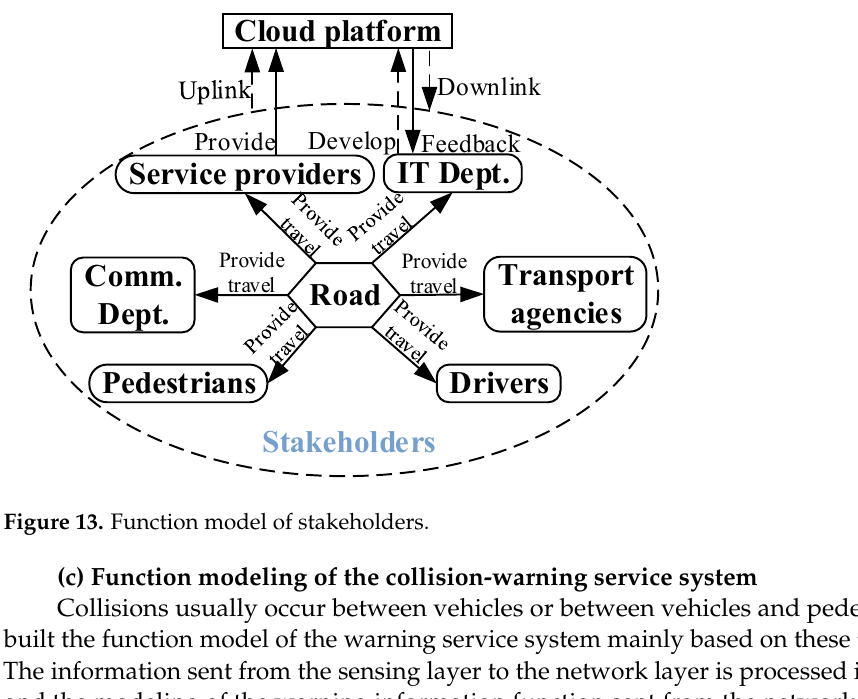
for the driver to brake. This is performed through the vehicle’s audio/video interaction as shown in Figure 14.